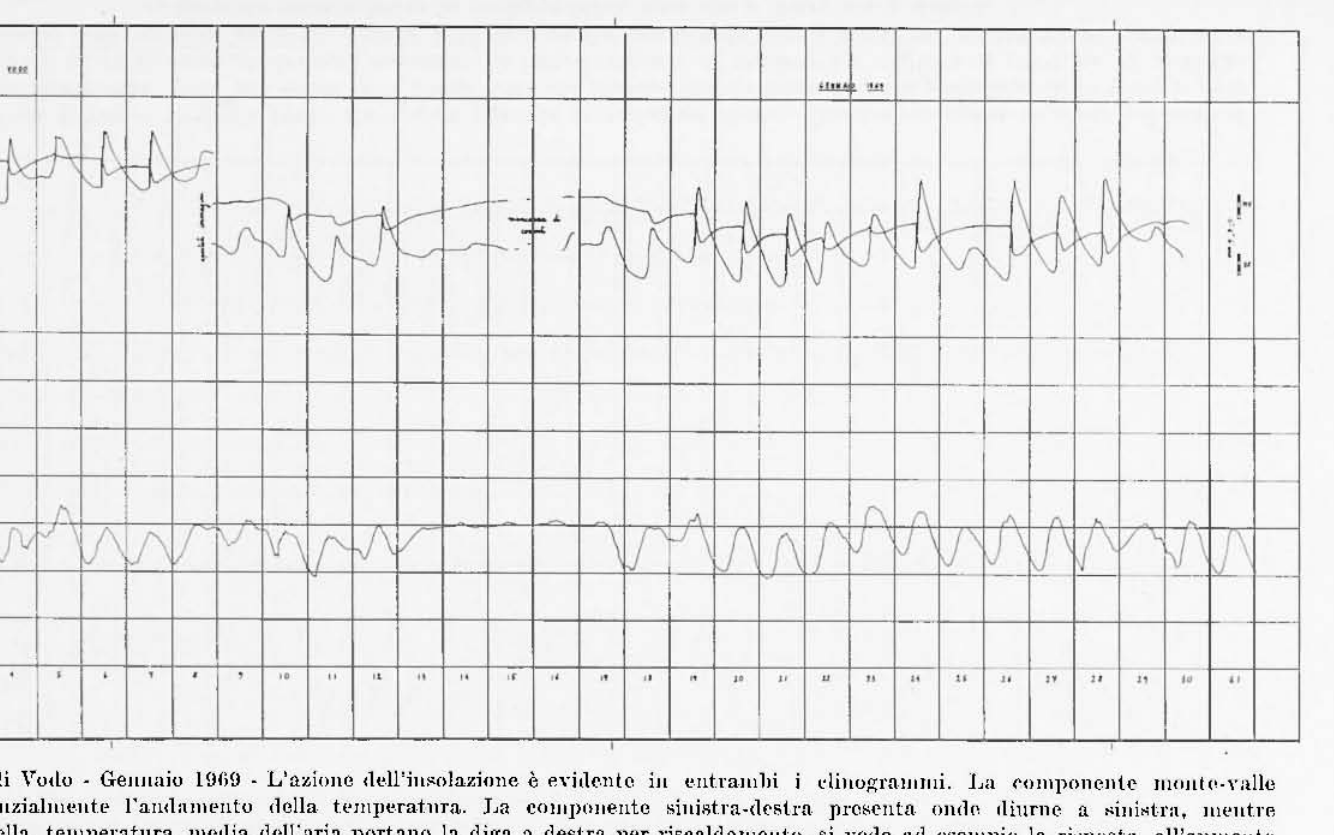
Fig. 3 - Diga Ili Vutlu - GeJllluiu lUI,\) - L'aZiono (lI'U'ill~olaziolle è cvirknte ili l'lltralllllj i dillugrulllilli. La pOlllponcnte lIlo11(p."alie rispecchia sU8tallziahlll'llte l'alUlamt'lltu Ilella tl'Ill]H'TatllTu,. L:l CO!III)(>IIIò"nte 8illistra·d('~tra prc~ellta o]Hln llillrnc il "illl"tra,